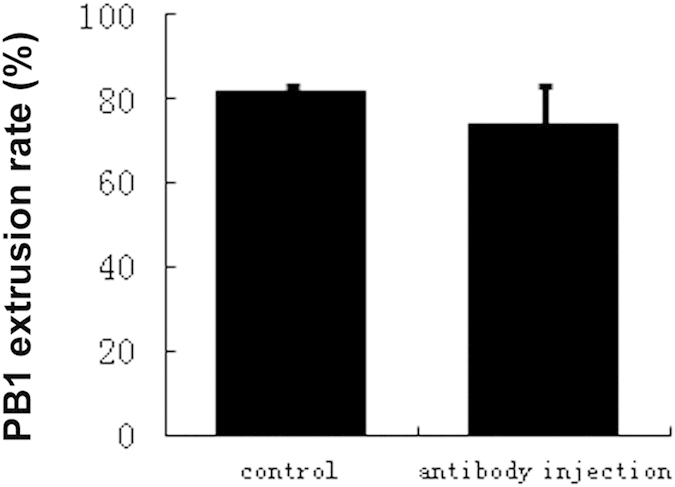
Cep55 immuno-blocking does not affect the PB1 extrusion rate in anaphase oocytes.Cep55 antibody was microinjected into oocytes after 9–9.5 h of culture, then transferred to M16 medium for 5 h of additional culture. Data are presented as means + -SEM of 3 independent experiments (p > 0.05).